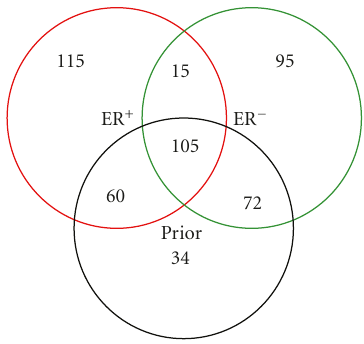
Figure 9: Common and specific recovered